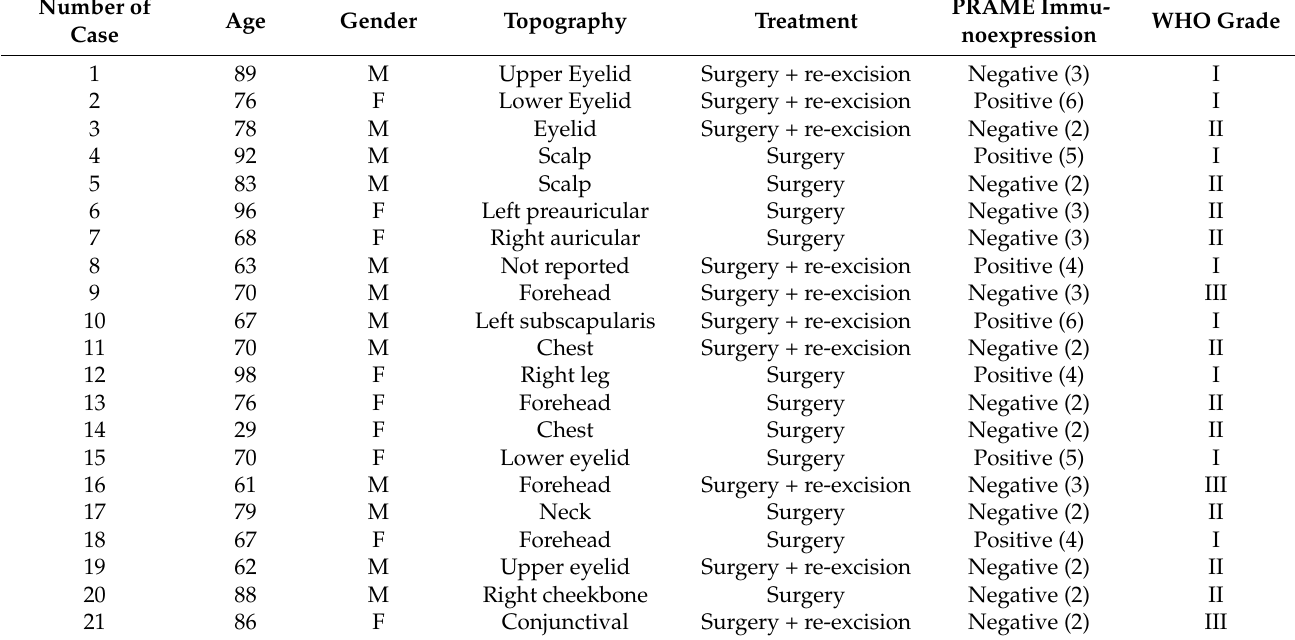
Table 1. Clinical, topographical and surgical features of the SC included and studied in this paper. Note the number in the brackets represent the value of composite score of